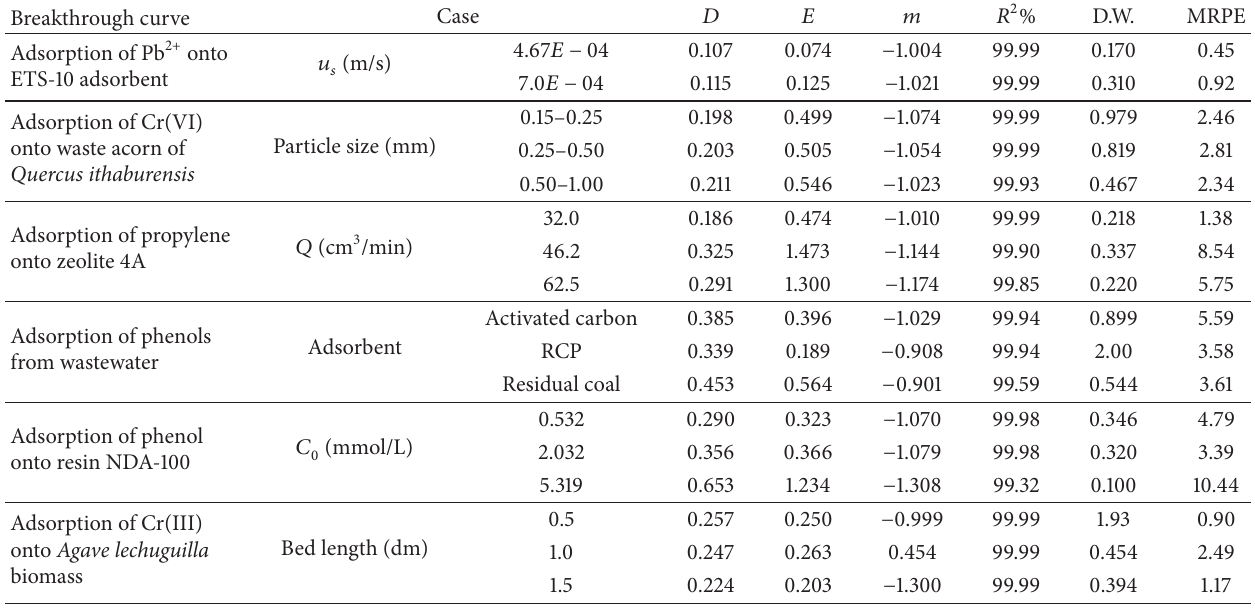
Table 5: Fitting different breakthrough curves based on (2), related statistical tests, and MRPE.